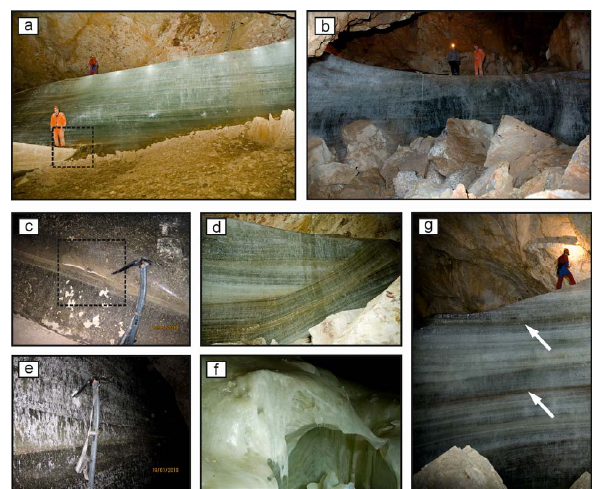
Figure 2: Photographs of characteristic basal (a-b) and internal (c-g) structures in the ice caves (a) The ice at "Feenpalast 1" (Dachstein-Mammuthöhle) with an interbedded boulder. The basal substrate consist of fine-grained sediments. (b) The ice at "Saarhalle" (Dachstein-Mammuthöhle) with large boulders on the base. (c) The diaphanous ice at "Feenpalast 1" with embedded thin layers of accumulated particles. A zone of high particle density is highlighted. (d) Subsurface parallel strata in the footwall and horizontal strata in the hanging wall found at "Feenpalast 2". (e) Detail of the diaphanous ice shown in a). Slight stratification is indicated by a variable content of millimetre-sized bubbles and a low amount of embedded particles. (f) The intransparent ice at Dachstein-Rieseneishöhle with a hole (diameter ~2 m) which has been formed by air currents. (g) Side view of the intransparent ice at "Feenpalast 2" and two sediment layers which are also seen as reflection bands in the radargram (Fig 3d).